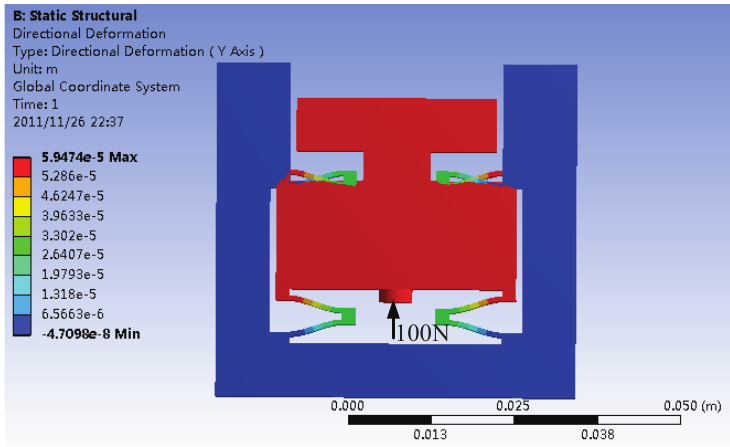
Figure 6. Static deformation under 100 N